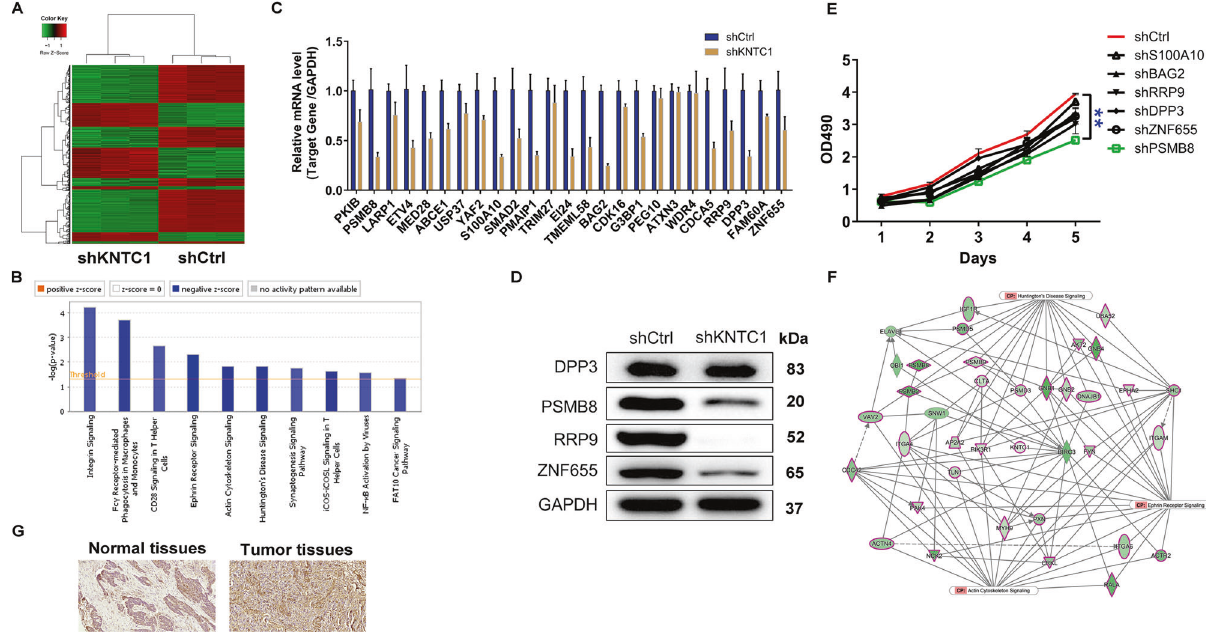
Fig. 3 Exploration the underlying mechanism of KNTC1 regulating NSCLC. A The heatmap of DEGs identi fi ed by RNA-sequencing of NCI- H1299 cells treated with shCtrl ( n = 3) or shKNTC1 ( n = 3). B The enrichment of the DEGs in canonical signaling pathways was analyzed by the IPA analysis. C , D The expression of several most signi fi cantly differentially expressed genes identi fi ed by qPCR ( C ) and western blot ( D ) in NCI- H1299 with shKNTC1. E MTT assay was performed to detect the levels of cell proliferation of NCI-H1299 cells after transfecting S100A10, BAG2, RRP9, DPP3, ZNF655 and PSMB8 corresponding lentiviruses. F The potential linkage of KNTC1, PSMB8 and Ephrin Receptor Signaling, Huntington ’ s Disease Signaling and Actin Cytoskeleton Signaling was illustrated via the IPA analysis. G The expression levels of PSMB8